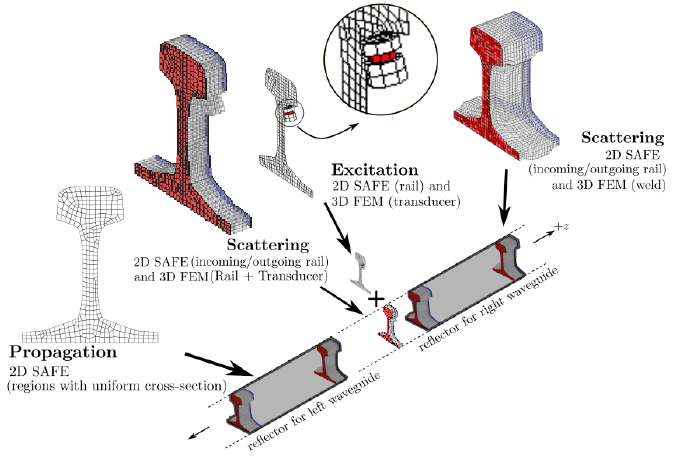
Figure 2. A digital model of the considered section of an operational